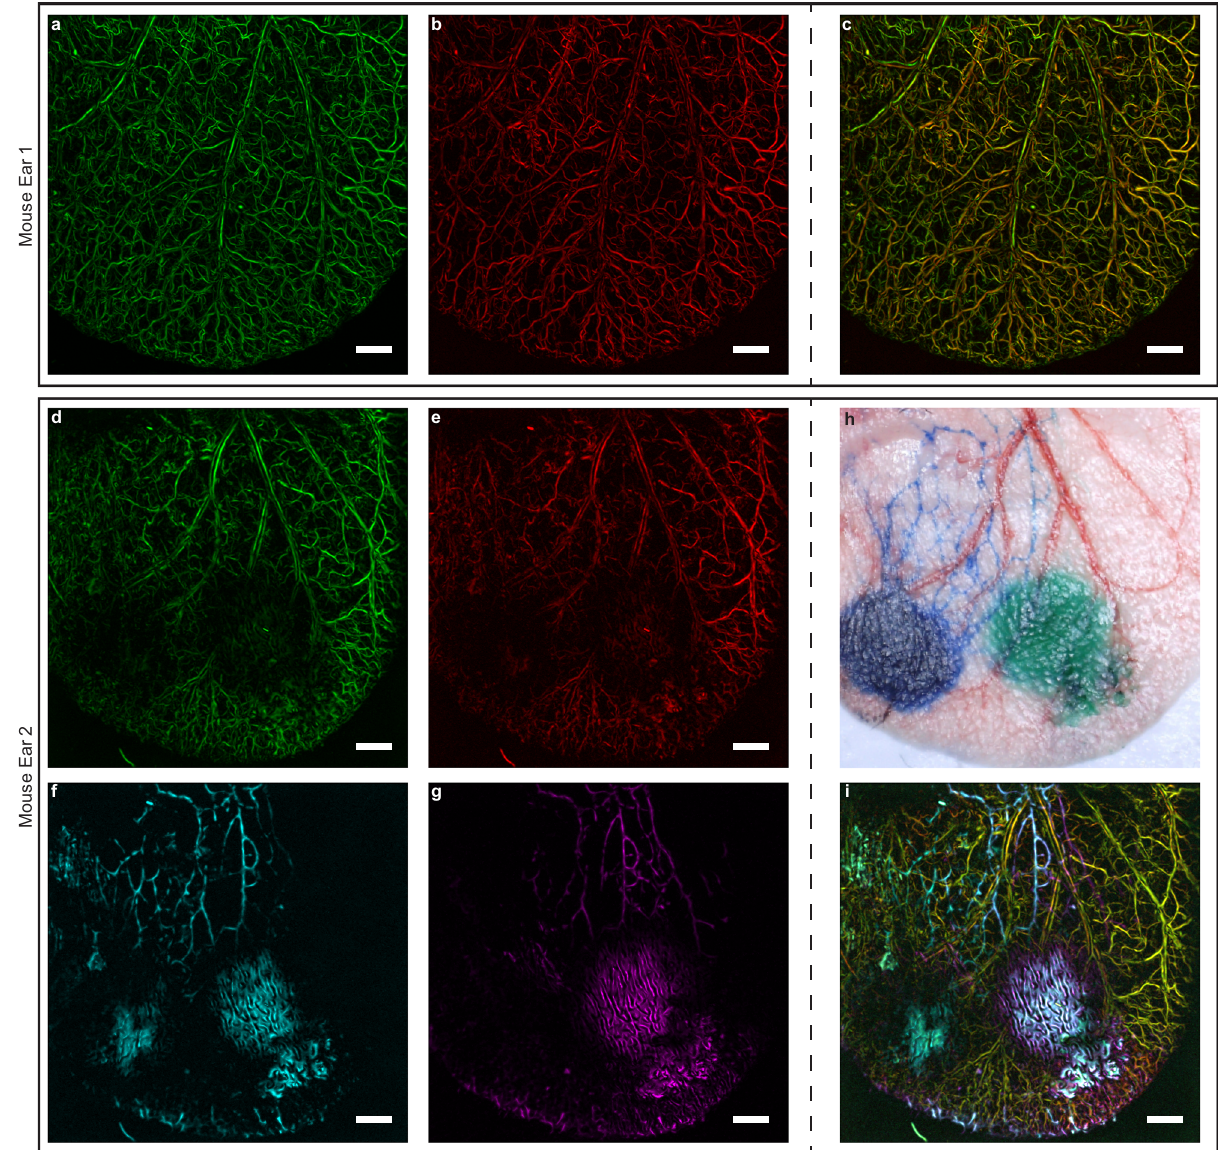
Fig. 3 | In vivo imaging using FWMOT. a and b A mouse ear at the two blue wavelengths, 445 and 465 nm respectively, with high spatial resolution. c The composite image color coded with red indicating higher oxygenation levels com- paredtogreen. d , e , f , g Asecondmouseearatallfourwavelengths. h Abright- fi eld image of the mouse ear. Intradermal injection spots of Evan ’ s Blue and ICG can be seen in images ( f , g , h ). f , g The injected dyes enter the lymphatic vessels that present a different structure than blood vessels. i The composite image of all four